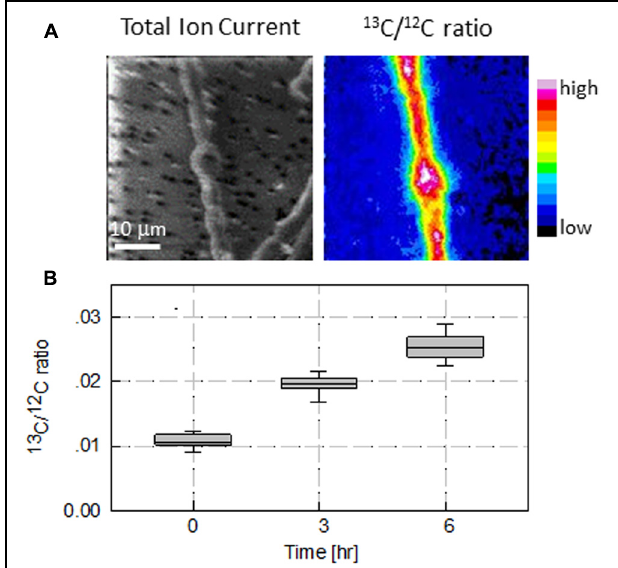
FIGURE 4 | Carbon assimilation in vegetative cells and akinetes in akinete induced culture as measured by nanometric scale secondary ion mass spectrometry (NanoSIMS). (A) Ion micrographs of vegetative cells and a young akinete and (B) quantitative estimation of carbon assimilation in vegetative cells incubated with H 13 CO − 3 for 6 h. Images in (A) are of total ion count (TIC) – left panel, and calculated 13 C/ 12 C ratio based on NanoSIMS analysis (color scale ranged from 0.0115 to 0.0275) – right panel. The summarized data in the box plot (B) indicates time dependent increase in 13 C/ 12 C ratio in photosynthetically active vegetative cells. The lower boundary of the box indicates the 25th percentile, a solid line within the boundary marks the average and the upper boundary of the box indicates the 75th percentile. Whiskers above and below the box indicate the 95th and 5th